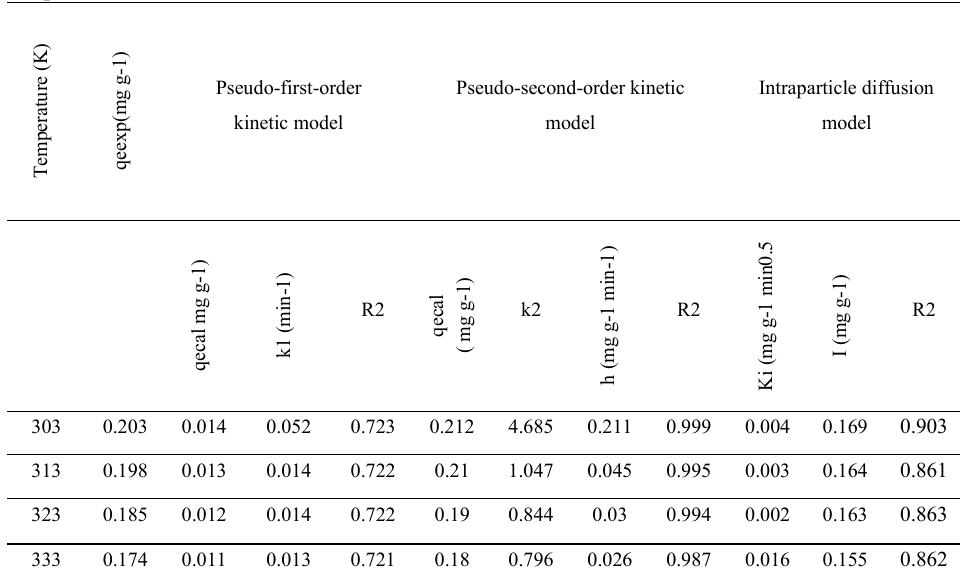
Table 4. Kinetics parameters for adsorption of fluoride onto eggshell powder at different